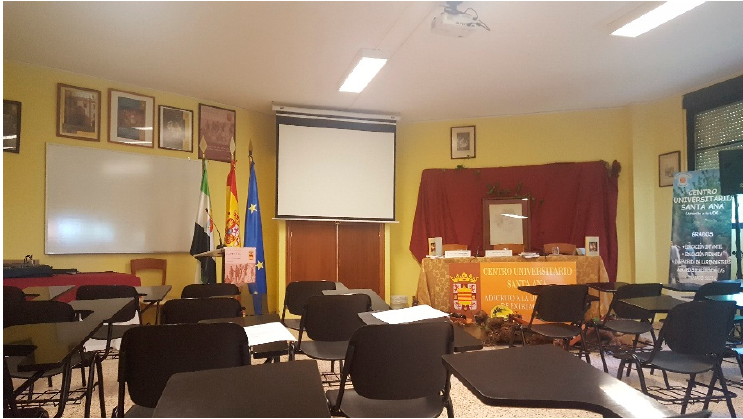
Figure 1. Room where the Conference of Viticulture and Oenology takes place.